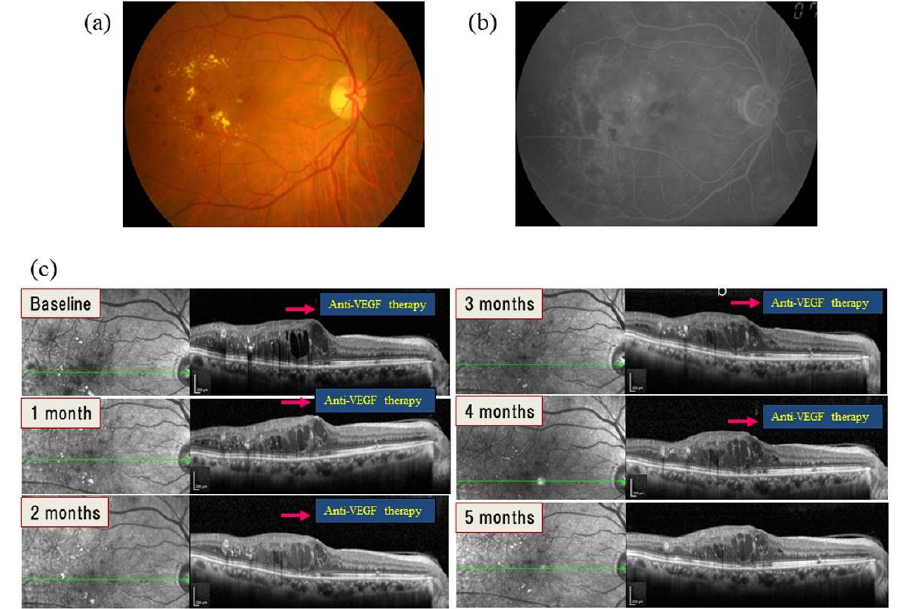
Figure 2. Images from a representative patient with diabetic macular edema (DME; male, 64 years old) in whom anti-vascular endothelial growth factor therapy was ineffective for diabetic macular edema. ( a ) Color fundus photograph of diabetic macular edema (DME) at baseline. ( b ) Fluorescein angiogram showing DME at baseline. ( c ) Optical coherence tomography images of DME from baseline to 5 months. DME did not improve despite five consecutive monthly doses of anti-vascular endothelial growth factor (anti-VEGF) therapy. Aqueous humor was collected at baseline and at the fifth injection for assessment of VEGF and other cytokines. Inflammatory factors were found to be elevated even though VEGF levels decreased (VEGF, 51.4 pg/mL → 0 pg/mL; monocyte chemoattractant protein (MCP)-1, 1601 pg/mL → 1915 pg/mL; intercellular adhesion molecule 1 (ICAM-1), 18.58 pg/mL → 22.72 pg/mL; interleukin (IL)-6, 8.86 pg/mL → 30.23 pg/mL;